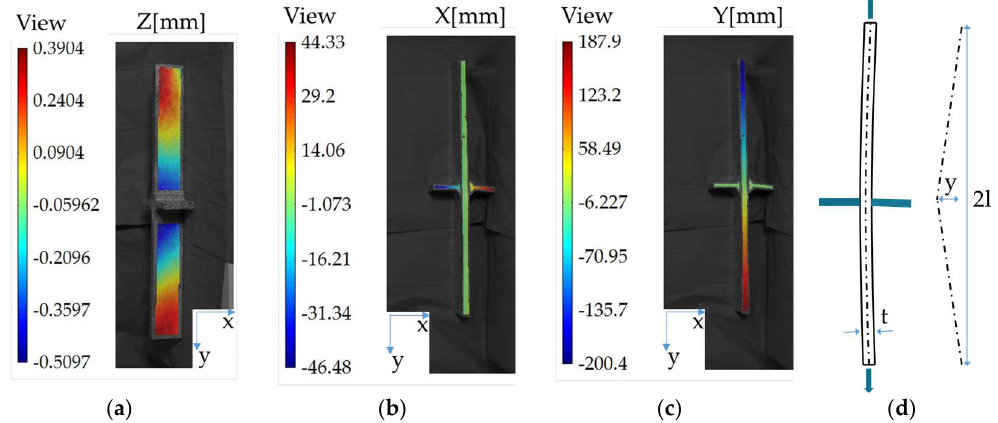
Figure 3. Geometric imperfections: ( a ) Out of plane straightness of the front view; ( b ) Horizontal axis straightness of the side view; ( c ) Vertical axis straightness of the side view; ( d ) Formulation for k m .